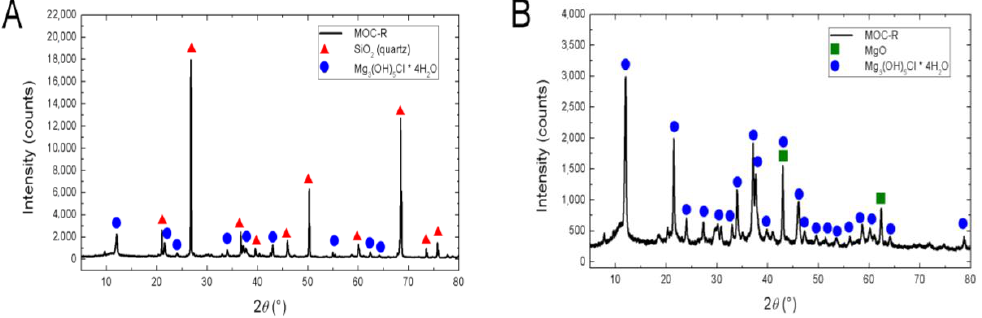
Figure 6. XRD diffraction pattern of ( A ) MOC-R and ( B ) MOC-EPP.